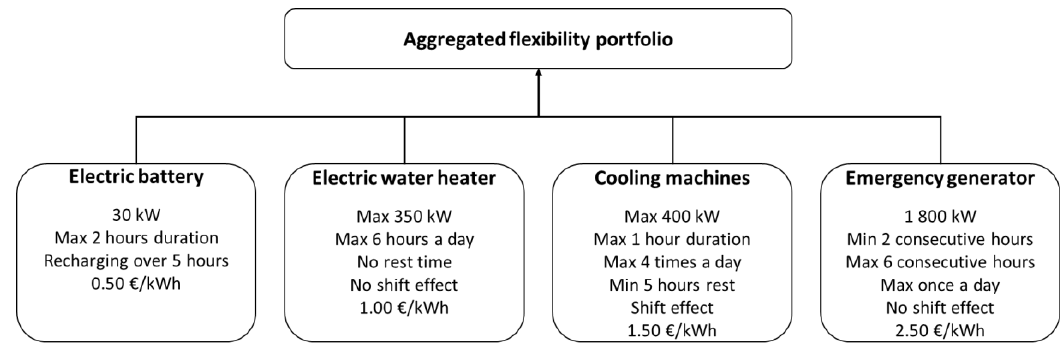
Figure 6 sums up the flexibility sources and their key parameters.